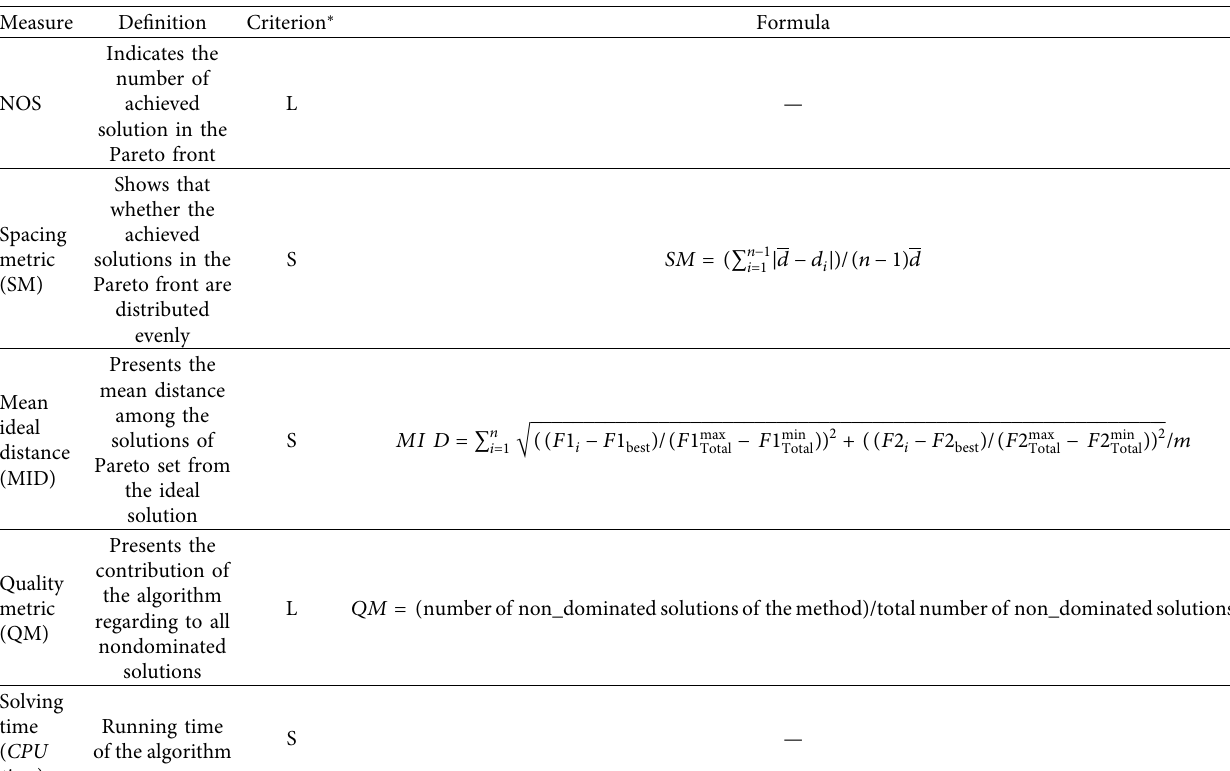
Table 3: Definition of performance